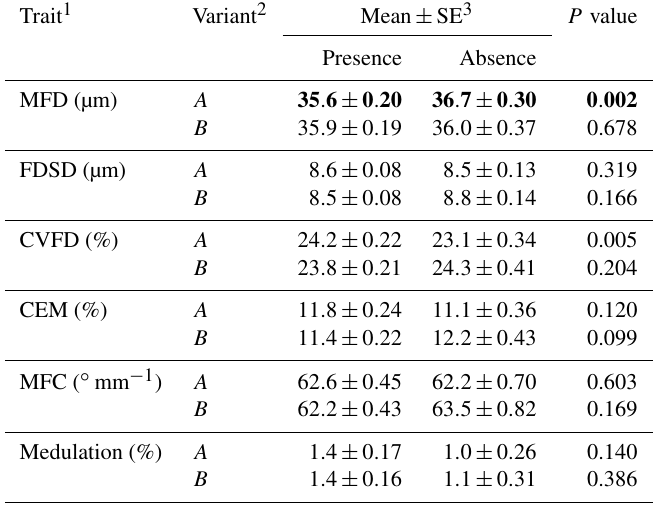
Table 1. Association between the presence or absence of ovine KRTAP6-1 variants and wool traits in New Zealand Romney ewes.